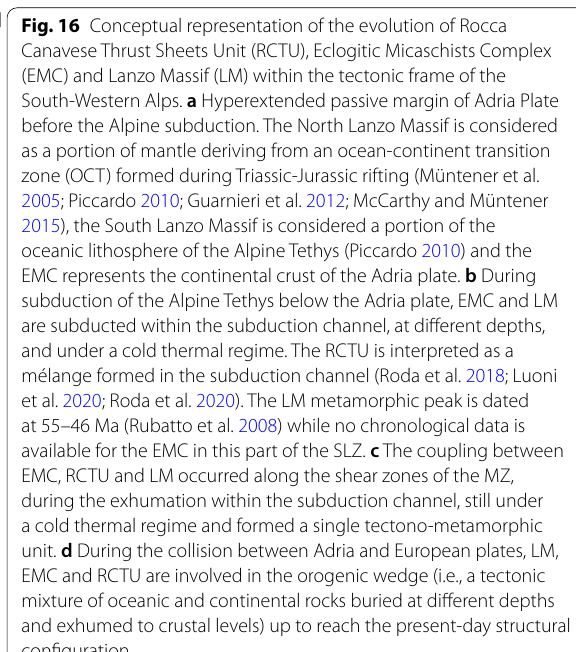
Fig. 16 Conceptual representation of the evolution of Rocca Canavese Thrust Sheets Unit (RCTU), Eclogitic Micaschists Complex (EMC) and Lanzo Massif (LM) within the tectonic frame of the South-Western Alps. a Hyperextended passive margin of Adria Plate before the Alpine subduction. The North Lanzo Massif is considered as a portion of mantle deriving from an ocean-continent transition zone (OCT) formed during Triassic-Jurassic rifting (Müntener et al. 2005; Piccardo 2010; Guarnieri et al. 2012; McCarthy and Müntener 2015), the South Lanzo Massif is considered a portion of the oceanic lithosphere of the Alpine Tethys (Piccardo 2010) and the EMC represents the continental crust of the Adria plate. b During subduction of the Alpine Tethys below the Adria plate, EMC and LM are subducted within the subduction channel, at different depths, and under a cold thermal regime. The RCTU is interpreted as a mélange formed in the subduction channel (Roda et al. 2018; Luoni et al. 2020; Roda et al. 2020). The LM metamorphic peak is dated at 55–46 Ma (Rubatto et al. 2008) while no chronological data is available for the EMC in this part of the SLZ. c The coupling between EMC, RCTU and LM occurred along the shear zones of the MZ, during the exhumation within the subduction channel, still under a cold thermal regime and formed a single tectono-metamorphic unit. d During the collision between Adria and European plates, LM, EMC and RCTU are involved in the orogenic wedge (i.e., a tectonic mixture of oceanic and continental rocks buried at different depths and exhumed to crustal levels) up to reach the present-day structural